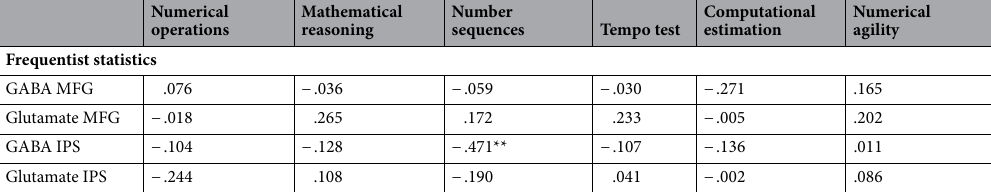
Table 3. Correlation matrix (correlation coefficients) depicting the associations between the numerical measures and neurotransmitter concentrations. **0.01 level (2-tailed), *0.05 level (two-tailed) uncorrected.